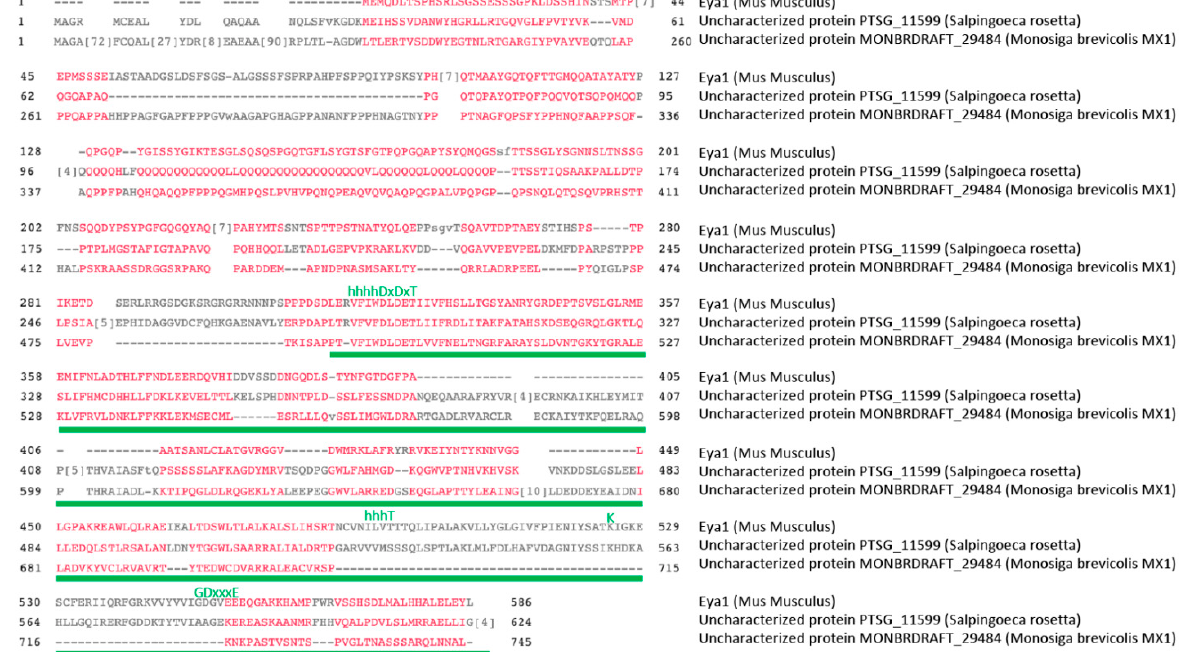
Figure 5. Amino acid sequence alignment of mouse Eya1 with the predicted proteins from two choanoflagellate species that contain a putative EYA domain. Characteristic HAD sequence motifs are shown above the alignment in green letters. The ED is indicated by the green line. BLAST searches were performed using www.ncbi.nlm.nih.gov/blast (accessed on 20 February 2021). domain enhanced lookup time accelerated BLAST(DELTA-BLAST) was used to find ED domains. Alignments were obtained using MULTALIGN (www.multalign.tolouse.fr) (accessed on 20 February 2021) and CLUSTAL Omega (https://www.ebi.ac.uk/Tools/msa/clustalo/) (accessed on 20 February